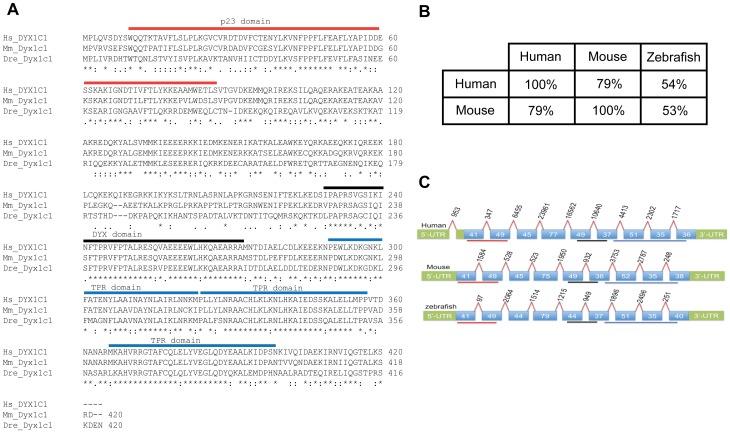
Sequence alignment and genomic structure of the vertebrate DYX1C1/Dyx1c1/dyx1c1 genes and proteins.Sequence comparison of zebrafish (Danio rerio; Dre) Dyx1c1 protein with that of Human (Homo sapiens; Hs) and mouse (Mus musculus; Ms) protein sequences (A). The p23, DYX and TPR domains are denoted by red, black and blue lines respectively. Protein sequence identity shown in percentage for the three species (B). The comparison of dyx1c1 cDNAs from Human, mouse and zebrafish reveals 9 exons intercepted by 8 introns (C). Human cDNA sequence shows the presence of an additional intron in the 5′untranslated region (UTR). The UTRs are denoted by green boxes, exons by blue boxes with the number of amino acids they code and introns are represented by slanting lines connecting the exons with the number of nucleotides (nt) on top. The conserved domains are denoted by red (for p23 domain), black (for DYX domain) and blue (for TPR domain) lines below the cDNA structure for each species.